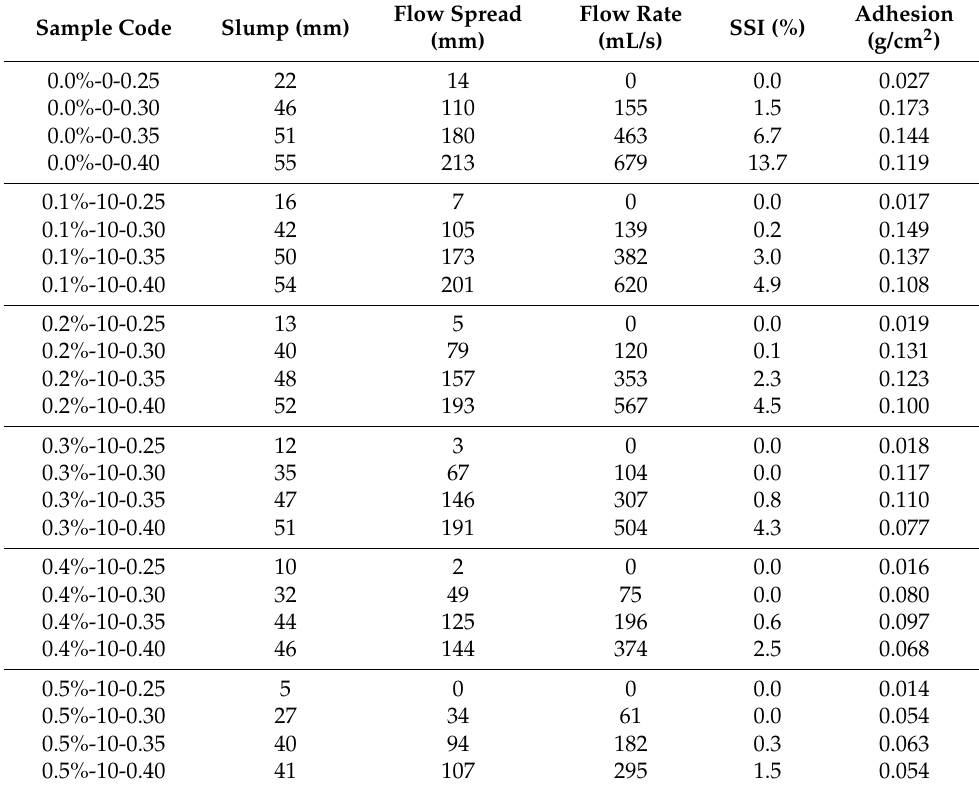
Table 3. Test results of mortar samples with varying fibre dosage and length = 10